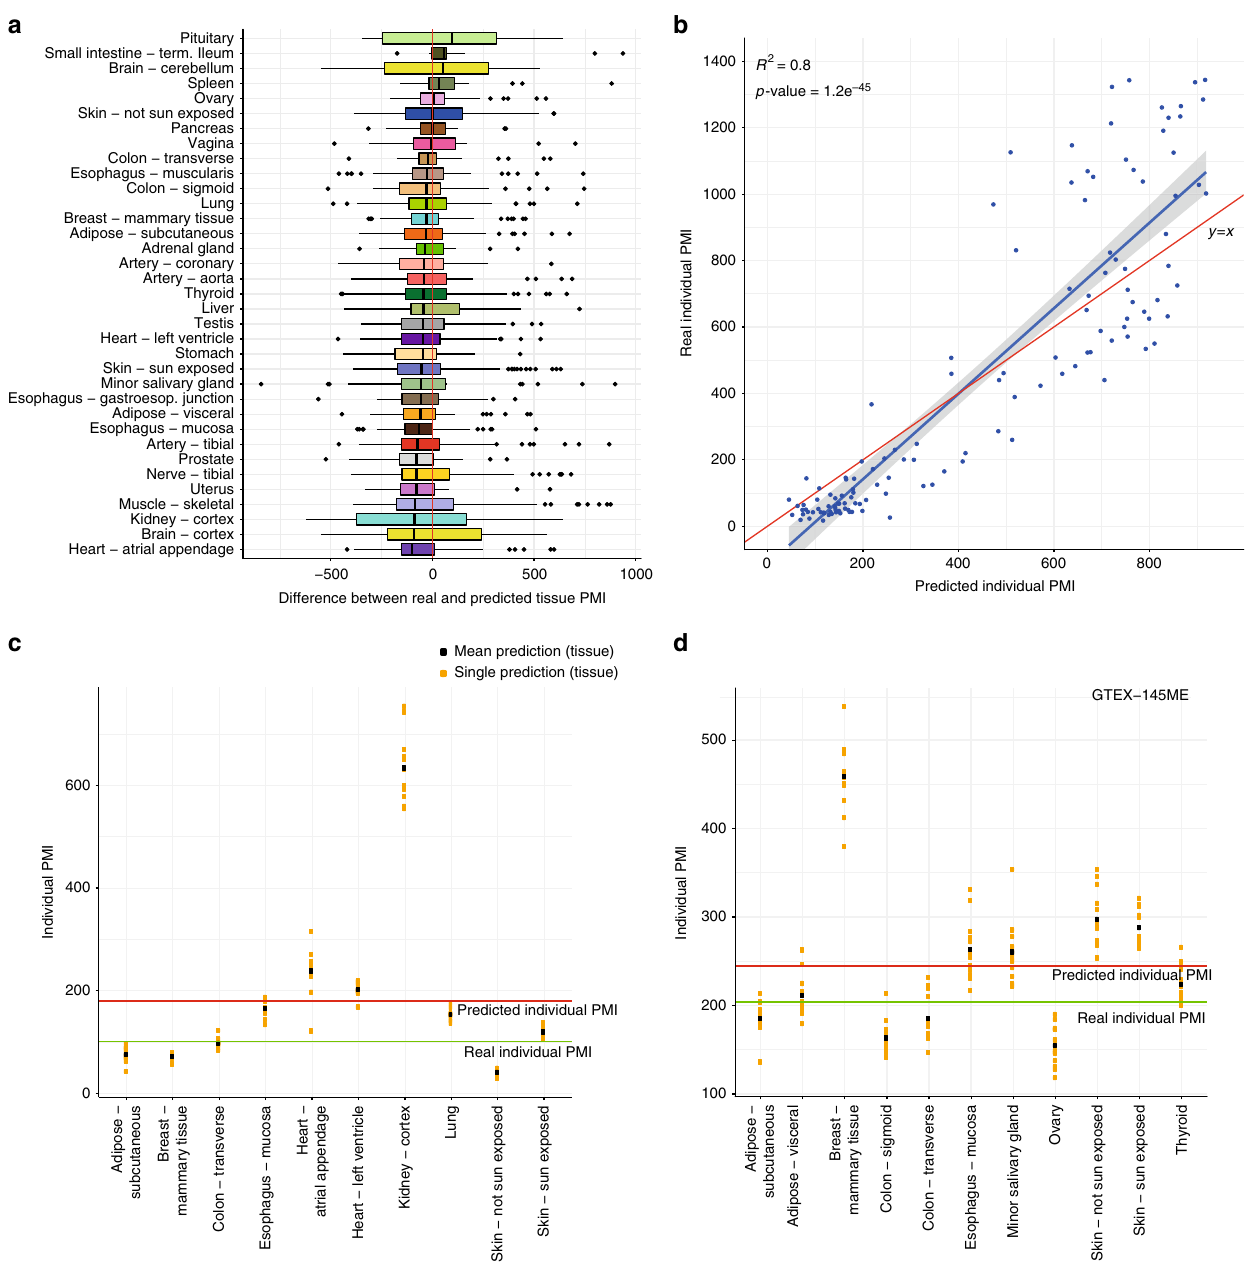
Fig. 8 Prediction of the PMI from gene expression in post-mortem samples. a Distribution of the PMI prediction error per tissue. b Regression of the real PMI versus the predicted individual PMI on the test set of 129 individuals. Plots in panels ( c ) and ( d ) illustrate two examples (GTEX-145MN and GTEX- 145ME) of the prediction of the PMI for an individual based on the prediction of PMI from each tissue from the individual. For a given tissue, each yellow dot represents a prediction from each one of 13 different models. The black dot is the mean prediction of these 13 models. The green line represents the real PMI value for the individual. The individual PMI prediction is calculated as the average of the fi nal tissue PMI predictions, and is represented by the red